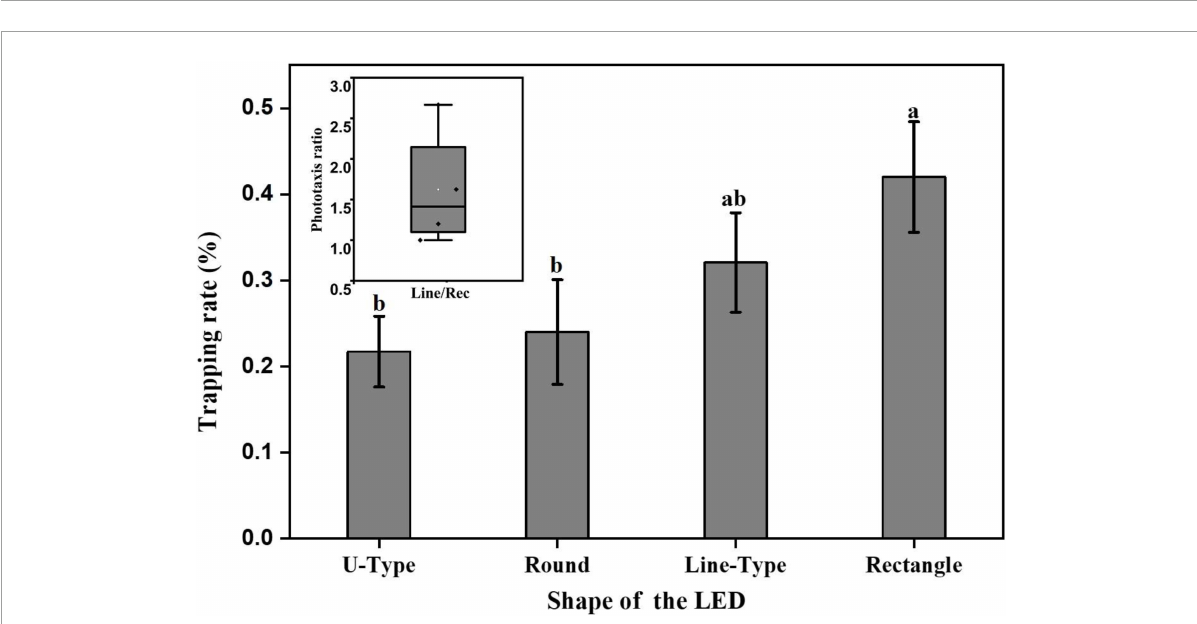
FIGURE10 Phototaxis response rates of L. striatellus with different light source shapes. Each value represents the trapping rate T 1 of the adult L. striatellus for that shape. Different letters above each group of data indicate significant differences between treatments ( p < 0.01). The upper left panel shows the phototaxis rate T 2 of linear and rectangular light